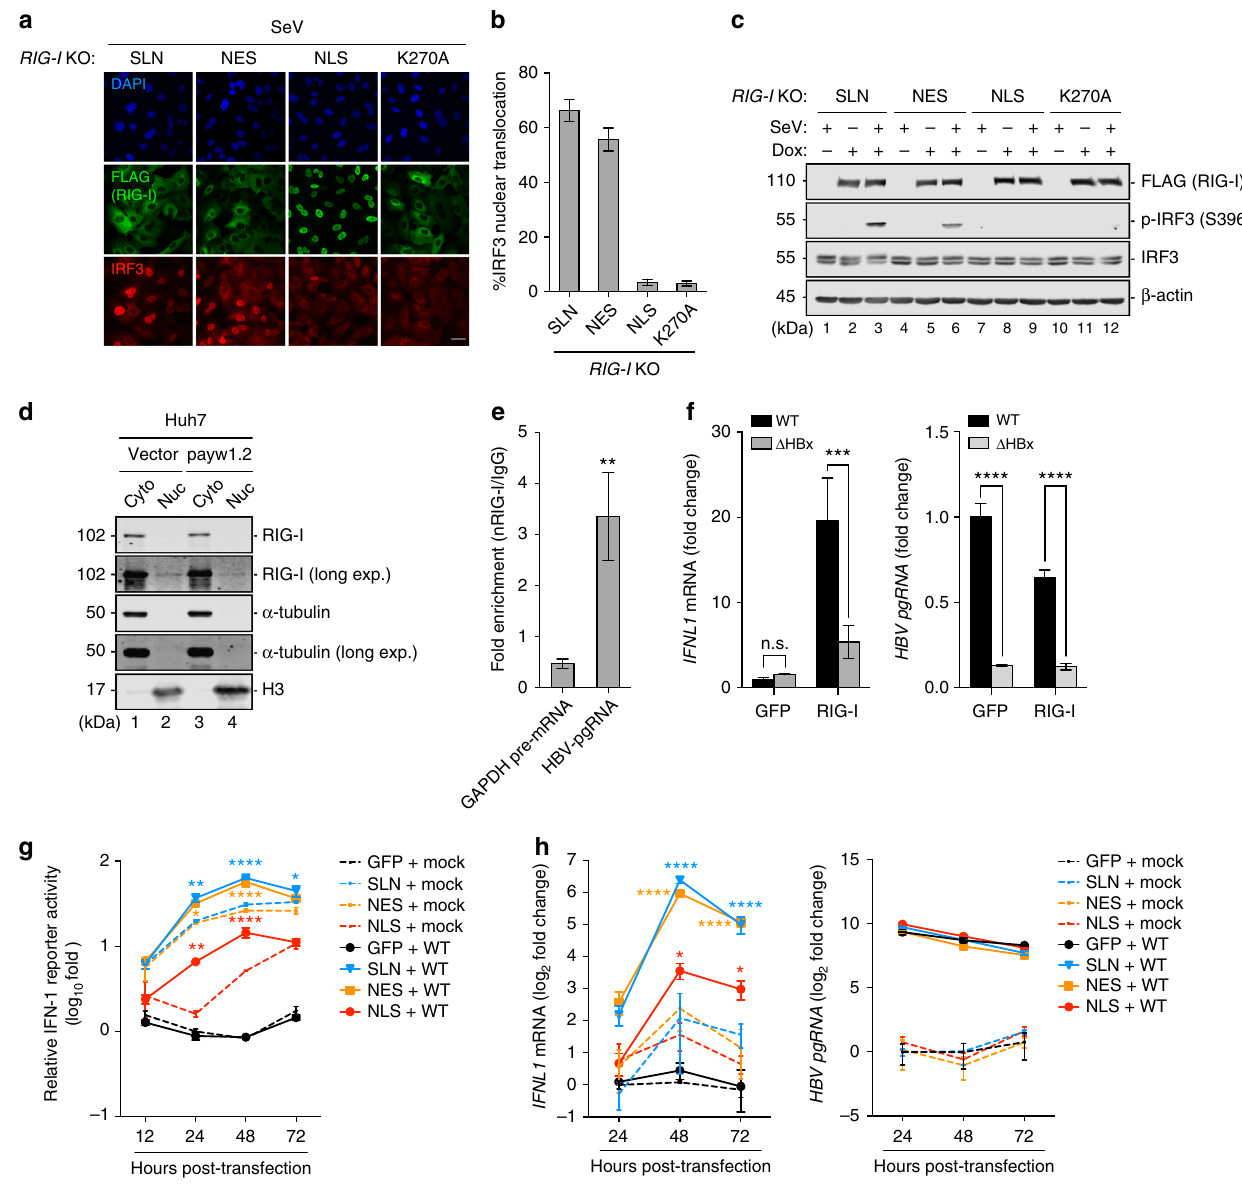
Fig. 6 Nuclear RIG-I exhibits compartment-speci fi c signaling capacity. a A549 RIG-I KO cell lines inducibly expressing SLN-RIG-I, NES-RIG-I, NLS-RIG-I, or K270A-RIG-I were induced with 1 μ g/mL Dox for 4 h, followed by infection with SeV (50 HAU/mL) for 7 h. Immuno fl uorescence was performed for FLAG- RIG-I (green) and IRF3 (red). Nuclei were stained with DAPI (blue). Scale bar = 25 μ m. b The percentage of cells positive for IRF3 nuclear translocation for each cell line ( a ) was calculated by quantifying ten random fi elds containing ~300 RIG-I-positive cells. c Dox-induced A549 cell lines were infected with SeV as in a . The protein expression was determined by immunoblotting. d The presence of RIG-I in both the cytoplasmic (Cyto) and nuclear (Nuc) fractions of stable Huh-7 cell lines was determined by immunoblotting. e RIP was performed using the nuclear extracts of Huh-7-pawy1.2 cells. The levels of HBV pgRNA and GAPDH pre-mRNA in IgG or RIG-I immunoprecipitates were determined by qRT-PCR and are expressed as fold enrichment in the nuclear RIG-I immunoprecipitate relative to IgG. f Huh-7.5 cells were cotransfected with WT or Δ HBx HBV genome along with plasmids encoding GFP or RIG-I for 48 h. The levels of IFN λ 1 mRNA and HBV pgRNA were determined by qRT-PCR. Fold change is expressed relative to the WT HBV transfection in the presence of GFP. g 293T cells were cotransfected with WT HBV genome along with plasmids encoding GFP or various RIG-I constructs, pGL-IFN λ 1- fLuc, and pTK-rLuc. RLUs at indicated h.p.t are expressed as fold change relative to the mock transfection in the presence of GFP at 12 h. h Huh-7.5 cells were mock transfected or transfected with WT HBV genome in the presence of GFP or various RIG-I constructs. Kinetics of IFN λ 1 mRNA and HBV pgRNA expression were determined by qRT-PCR. Fold change is expressed relative to the mock transfection in the presence of GFP at 24 h. Data are mean ± SD of two independent experiments and signi fi cant differences were determined by an unpaired Student ’ s t -test ( e – h ). * p < 0.05, ** p < 0.01, *** p < 0.001, **** p < 0.0001; n.s. not signi fi